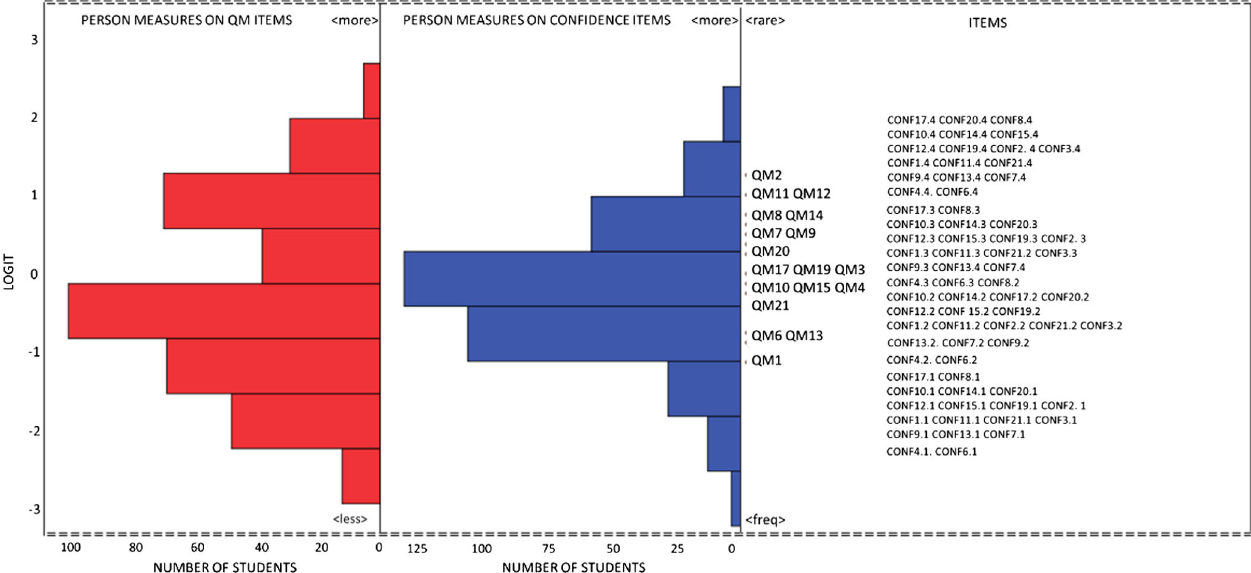
FIG. 4. Wright map of the questionnaire used in this study. Confidence items are labeled as CONF, knowledge items are labeled as QM. Thurstonian thresholds for confidence items are also shown (e.g., CONF9.4). The thresholds indicate the location at which the probability of choosing the ( i þ 1 )th category on the confidence scale is 50%. Items 5, 16, 18, 22 were removed from the analysis